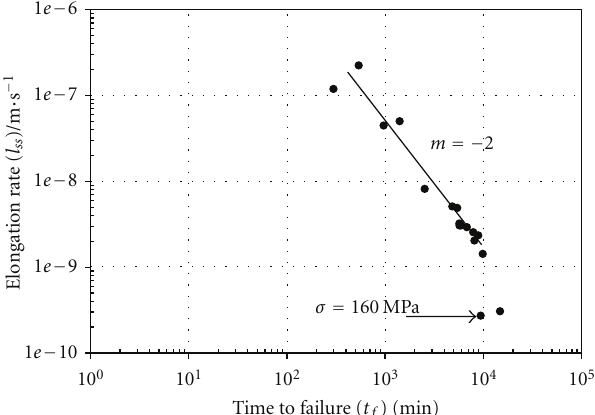
Figure 7: The relations between the logarithms of time to failure ( t f ) and steady-state elongation rate ( l ss ) for A5052-H3 in 0.5 M sodium chloride solution, where m is the slope of the straight